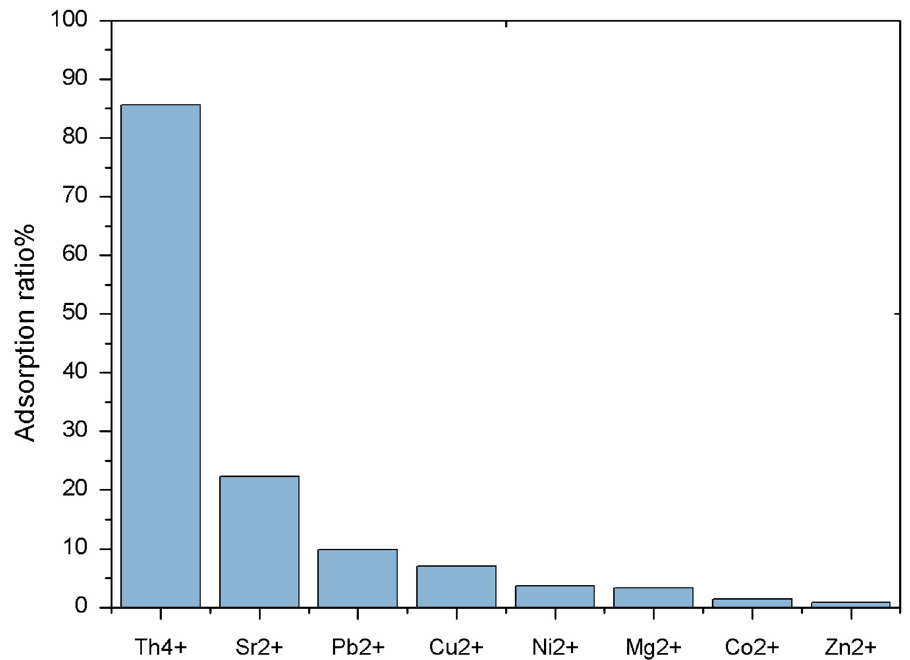
Figure 8. Selective adsorption of Th(IV) by AO-CELL. (Experiment conditions: solid/liquid ratio = 0.075 g/L; C 0 [Th(IV)] = 19.00 ± 0.10 mg/L; C 0 [M 2+ ] = 8.0 × 10 − 5 mol/L; pH = 3.00 ± 0.05; T = 298.15 ± 1.00 K; t = 0.5 h.) Table 3. The values of separation factor (S.F.) for Th 4+ versus seven metal ions.